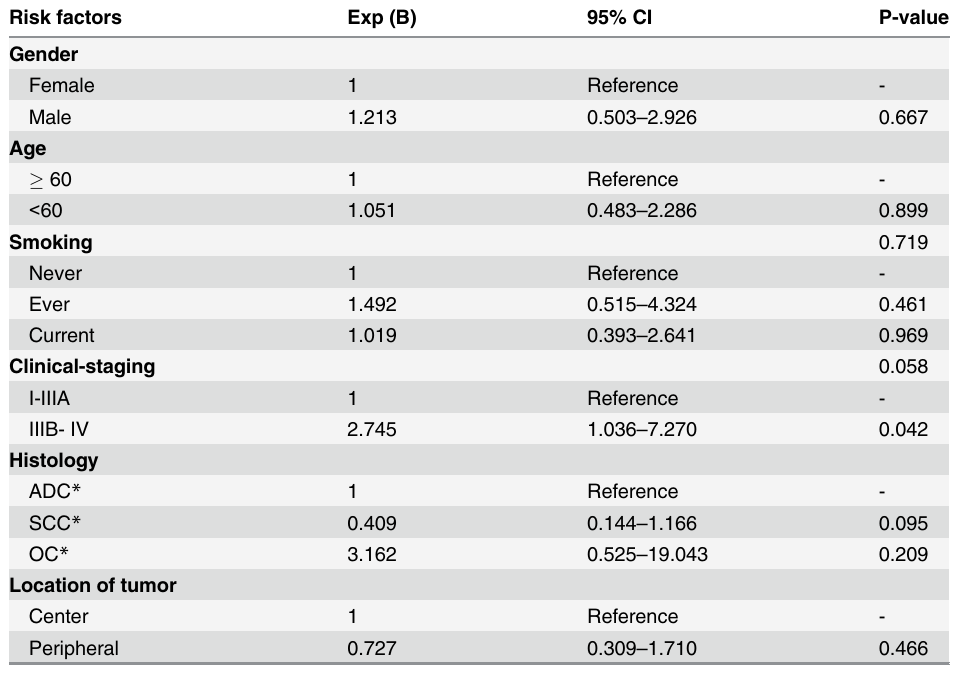
Table 3. Multivariate analysis of the CTC positive model with adjusted odds ratios and 95% CI.